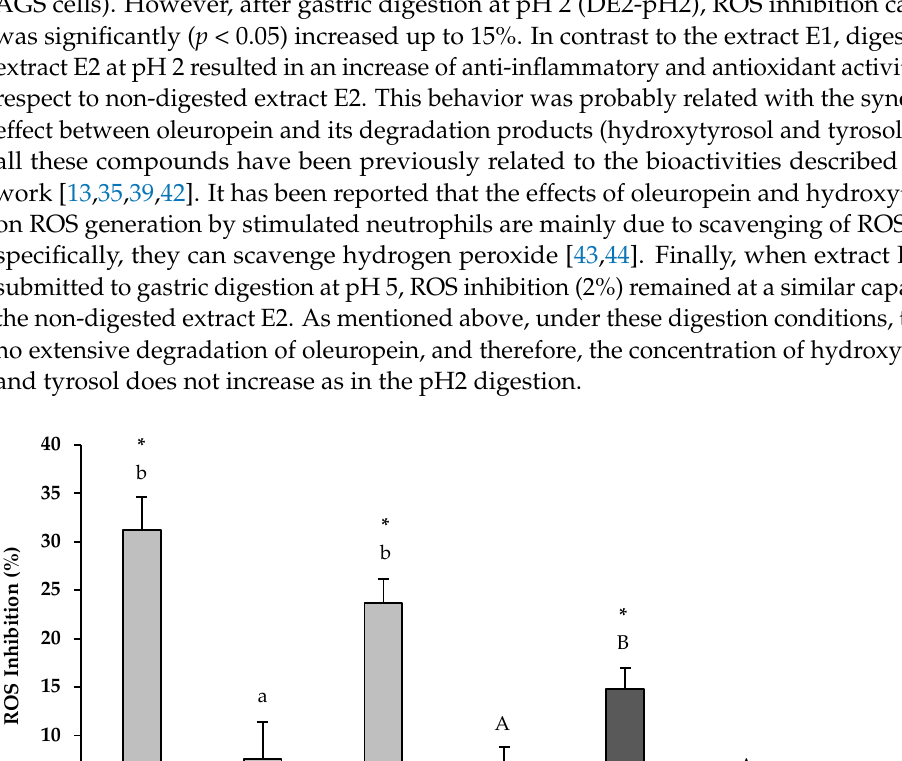
Table 2. Antibacterial activity of olive leaf extracts (E1 and E2) and their digested samples at pH 2 and pH 5 against H. pylori . Results represent the mean ± standard deviation of colony forming units (CFU)/mL (n = 3). Extracts